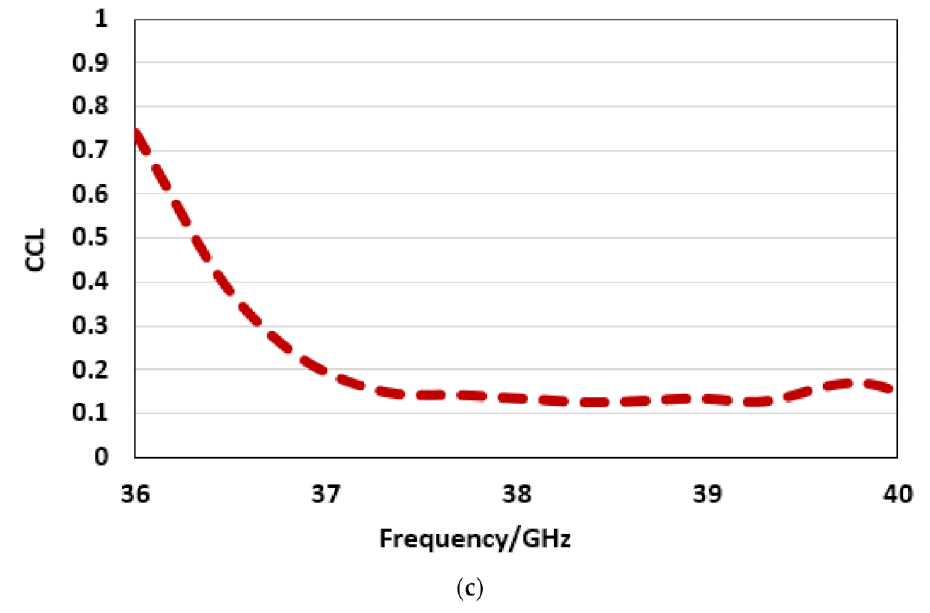
Figure 10. Corporate array MIMO configuration: ( a ) ECC, ( b ) DG, ( c ) CCL. 1.00 × 10 − 4